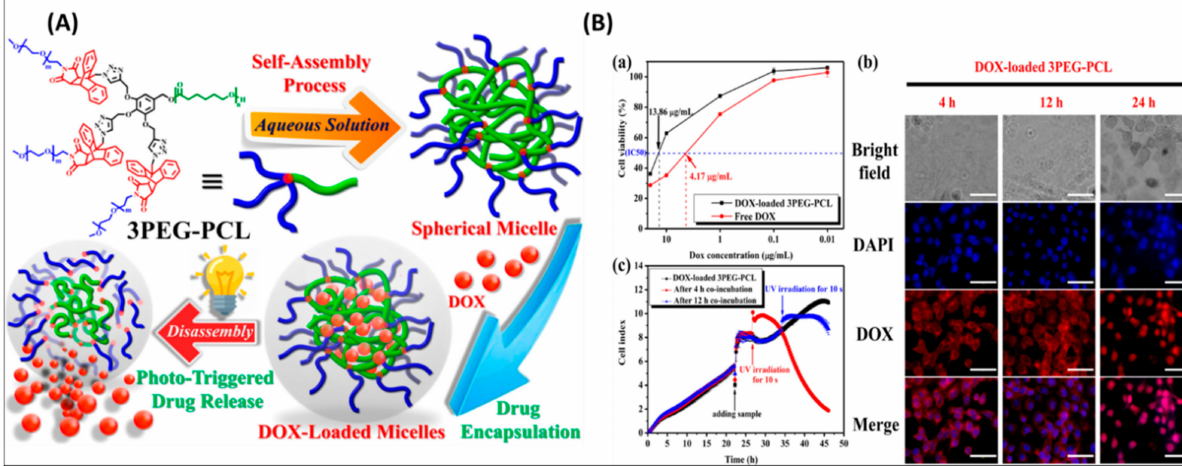
Figure 12. ( A ) The design strategy of 3PEG–PCL micelles for DOX loading and release strategy. ( B ) ( a ) toxicity test of human oral squamous cell carcinoma (SAS) cells. ( b ) Bioimaging results of SAS cells treated with DOX and DOX-encapsulated micelles. ( c ) Cytotoxicity profiles calculated form real time analyzer. Reprinted with permission from [189]. Copyright © 2019, American Chemical